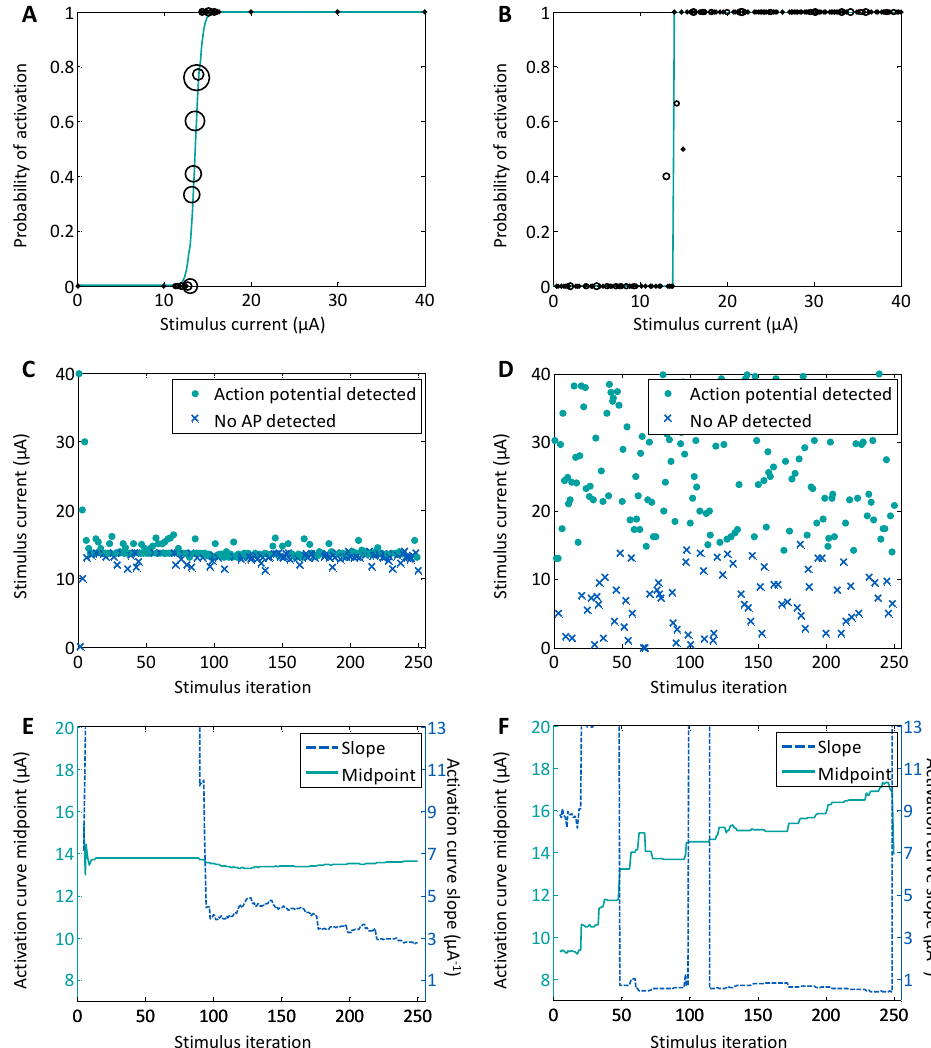
Figure 9. Closed-loop versus open-loop experiments. Two sets of 250 stimuli were delivered to the culture via one electrode. In the closed-loop experiment, the model-based algorithm selected the stimuli in real-time ( A , C , E ); and in the open-loop experiment a random set of stimuli were chosen from the stimulus pulse parameter space ( B , D , F ); ( A , B ) The best fit of a sigmoid from Equation (1) is plotted after the 250th stimulus iteration. The averaged response to each of the stimulus currents is depicted with open circles, which are proportional in size to the number of stimuli that were delivered. ( C , D ) The individual measured response to each stimulus is plotted as a dot to denote that an action potential was detected or an “X” to denote that no action potential was detected. ( E , F ) The convergence of the sigmoid midpoint (solid line, left y- axis) and slope (dotted line, right y- axis) is shown with stimulus iteration. The sigmoid activation model was calculated in real-time after each stimulus iteration for the CL experiment and was calculated post-hoc for the OL experiment. The OL fit parameters did not converge.